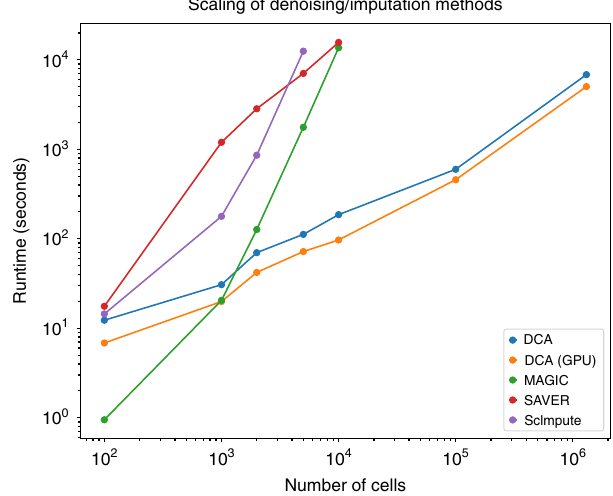
Fig. 7 DCA scales linearly with the number of cells. Plot shows the runtimes for denoising of various matrices with different numbers of cells down- sampled from 1.3 million mouse brain cells 44 . Colors indicate different methods. DCA (GPU) indicates the DCA method run on the GPU